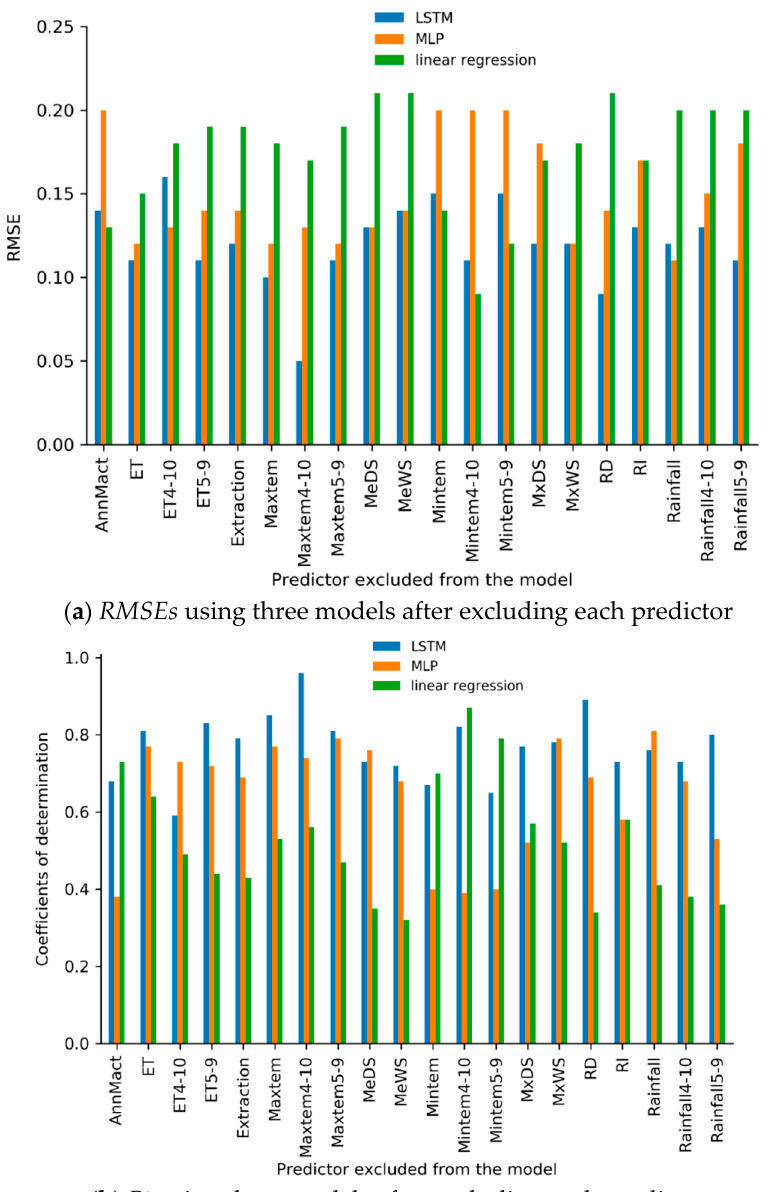
Figure 6. RMSE and coe ffi cients of determination ( R 2 ) using three models after excluding each potential influential predictor for the predicted groundwater recharge